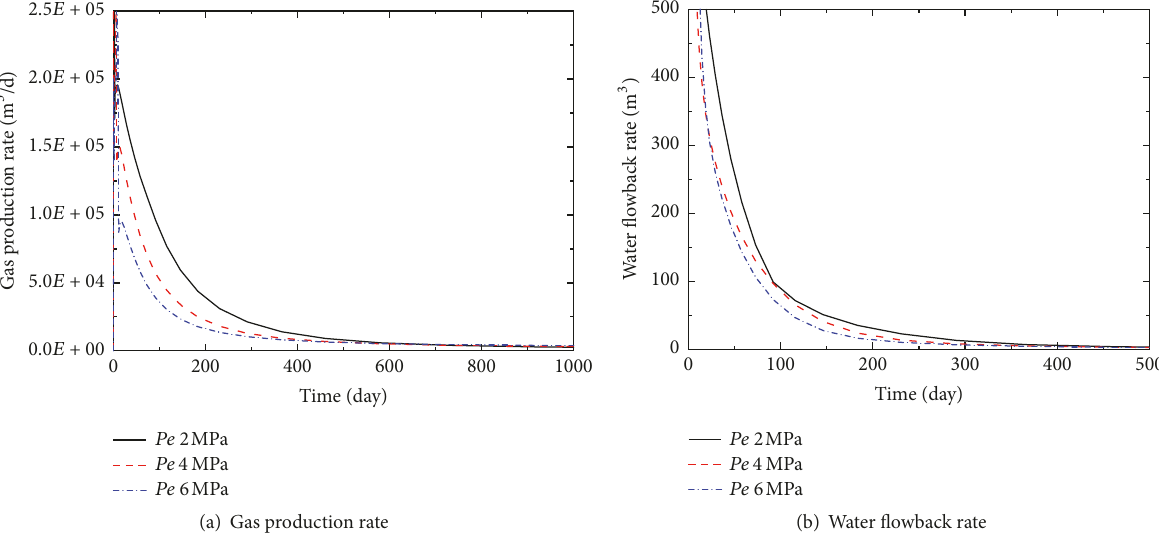
Figure 13: Impact of entry capillary pressure on gas and water flowback rates.